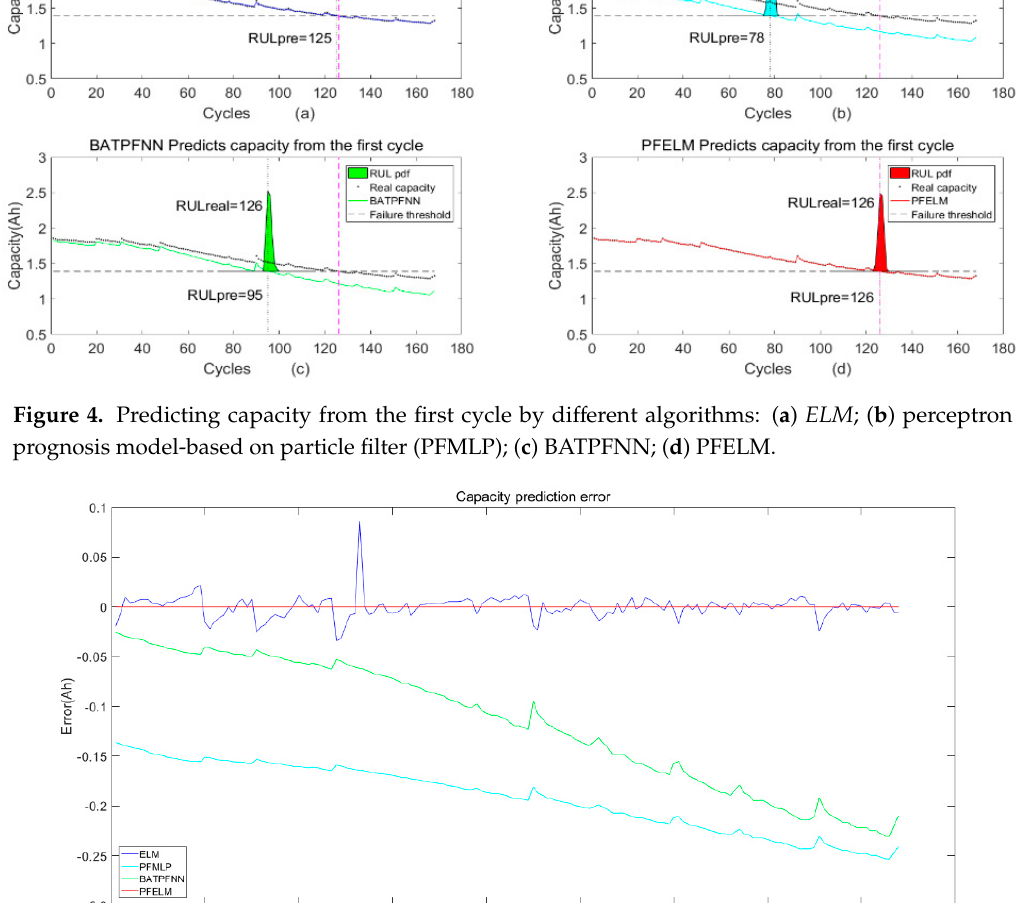
Figure 5. Capacity prediction error from the first